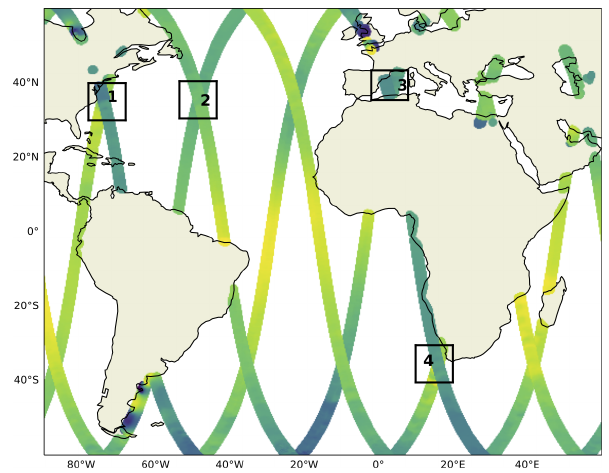
Figure 1. SWOT tracks during its calibration phase and strategic Xover regions in the Atlantic sector. The regions cover the Gulf Stream separation and its extension (Regions 1 and 2), the western Mediterranean Sea (Region 3), and the Agulhas Rings (Region